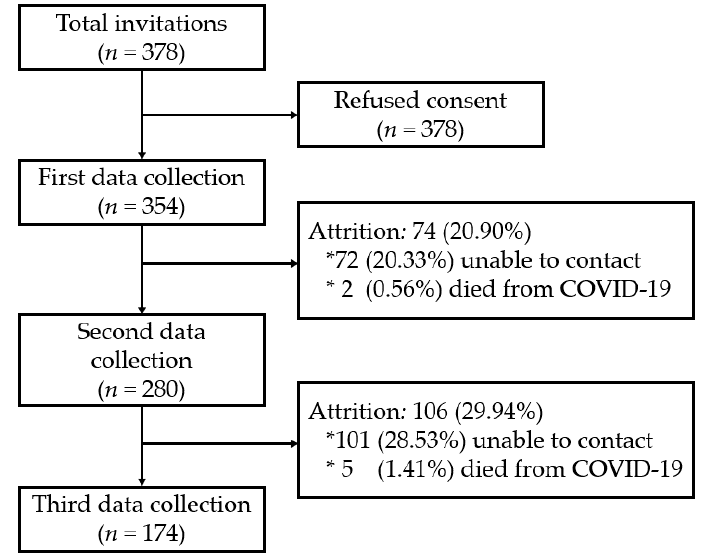
Figure 1. Flow chart of the study participants. Table 1. Descriptive data of the participants ( n =